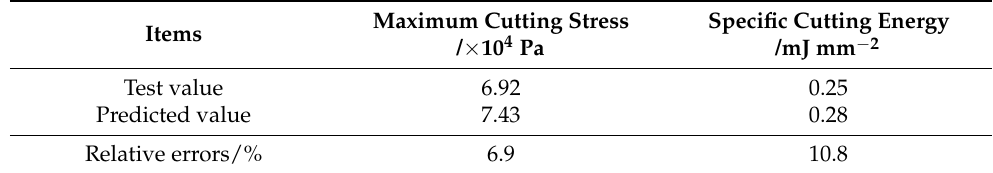
Table 5. Results of the verification test.